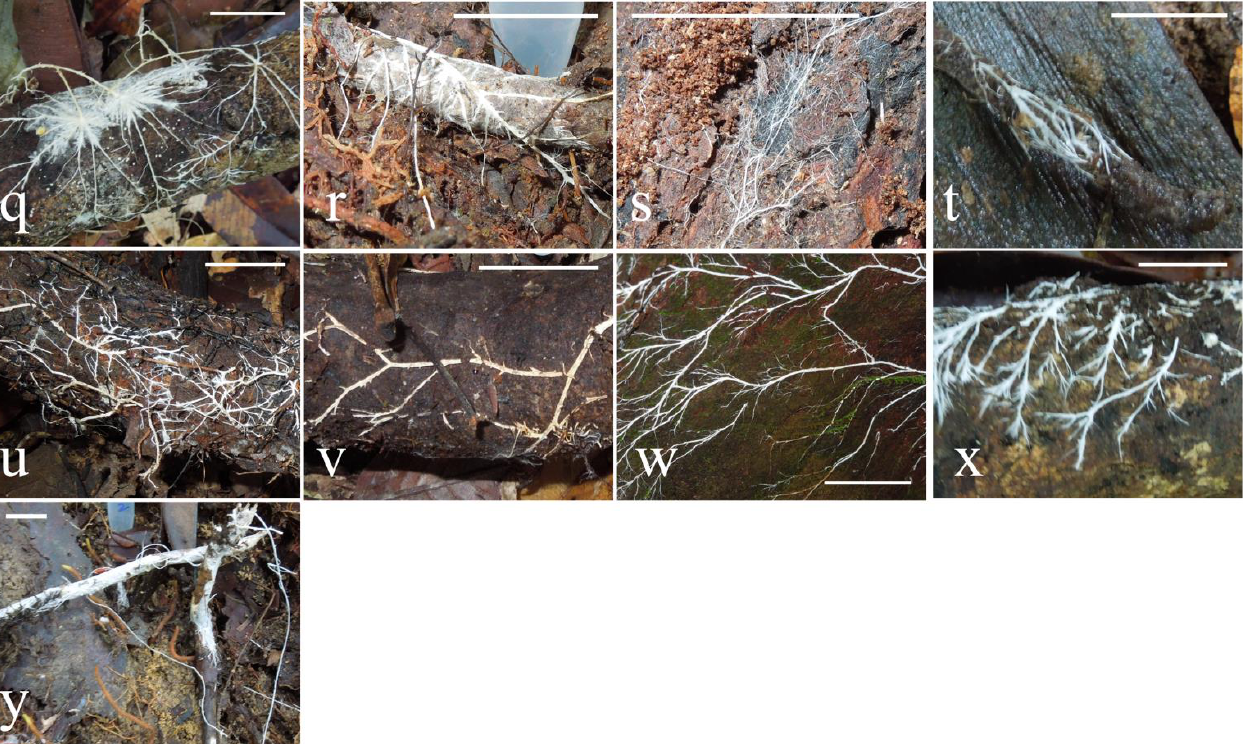
Figure 2. Photographs of fungi growing directly on tree branches in situ prior to collection. Scale bar is 2 cm. ( q ) BOR98, ( r ) BOR102, ( s ) BOR85, ( t ) BOR203, ( u ) BOR101, ( v ) BOR105, ( w ) BOR100, ( x ) BOR97, ( y ) BOR90.